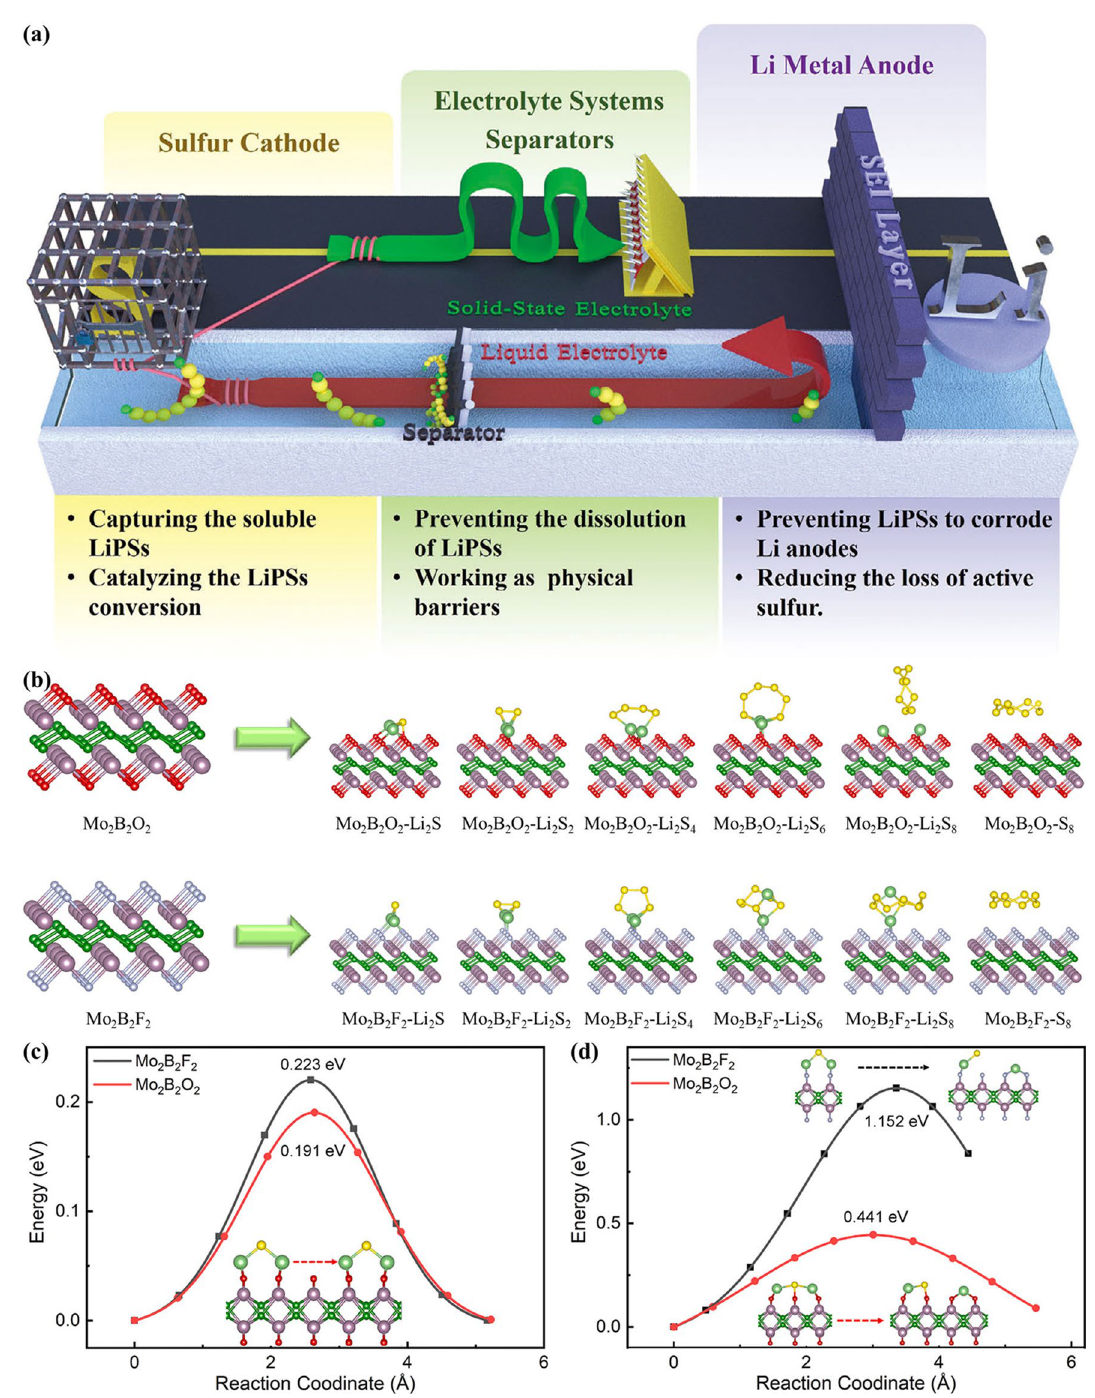
Fig. 24 a Schematic illustrations of the strategies and operation mechanisms of the modified sulfur host, electrolyte systems, functional separa- tors, and anode surface engineering for the inhibition of LiPSs shuttle. Reproduced with permission from Ref. [250]. b Left: Optimized struc- tures of Mo 2 B 2 O 2 and Mo 2 B 2 F 2 . Right: The most energetic favorable adsorption configuration of Li 2 S n (n = 1, 2, 4, 6 and 8) and S 8 on the surface of Mo 2 B 2 O 2 MBene and Mo 2 B 2 F 2 MBene. The purple, green, sky blue, red, yellow, and moss green spheres represent Mo, B, F, O, S, and Li atoms, respectively. The calculated energy curves of Li 2 S c diffusion and d decomposition on the surfaces of Mo 2 B 2 F 2 (black line) and Mo 2 B 2 O 2 (red line). Reproduced with permission from Ref. [249]. (Color figure